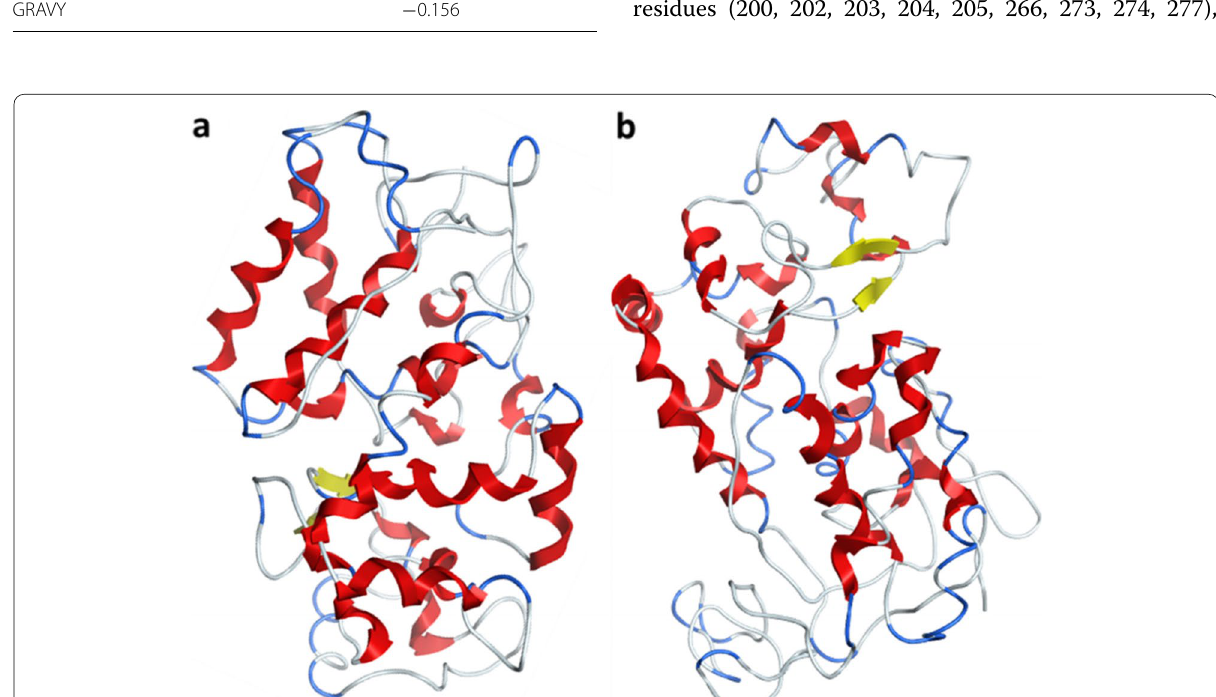
Fig. 3 a The SWISS‑MODEL generated 3D structures of Aspergillus niger AN512 peroxidase enzymes. b The predicted 3D structures by